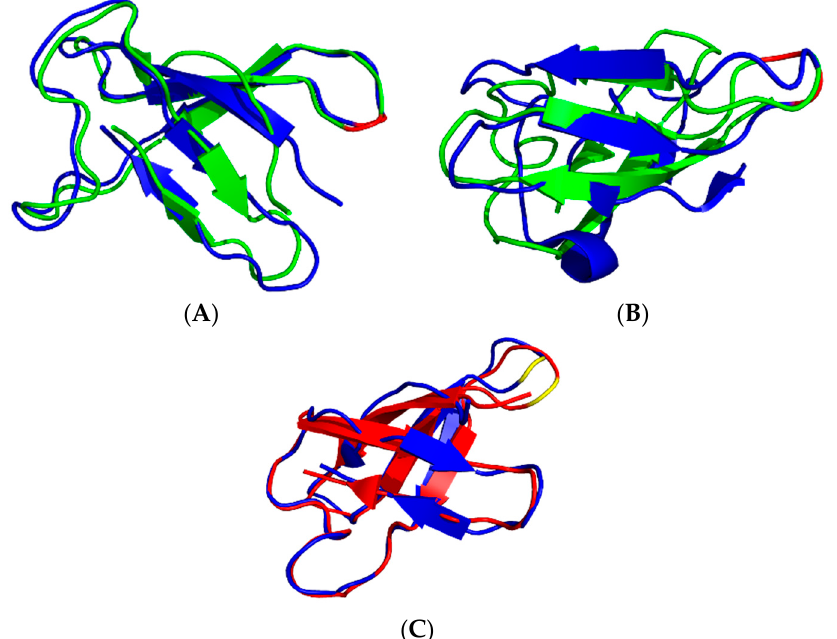
Figure 2. Comparison of the solution backbone structures in water (blue) and in 50% DMSO (green). PAF (2MHV vs. 7PGD) ( A ) and PAF D19S (2NB0 vs. 7NXI) ( B ). Overlaid structures of PAF (blue) and PAF D19S (red) as measured in 50% DMSO ( C ). The mutation site is labelled with red ( A , B ) or yellow ( C ). (PyMOL visualization software was used).